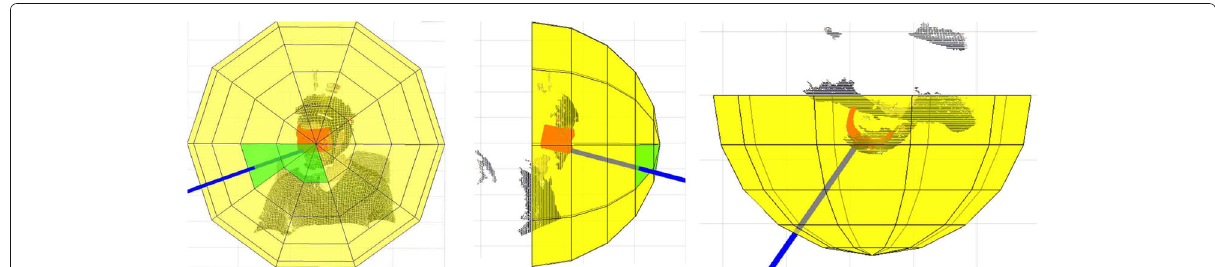
Fig. 3 Key frame learning process. Each figure represents the same target observed from three views. The discretized orientation is depicted as the region of the sphere. The color indicates visited areas (green) from regions without an associated pose (yellow). The set of points in red is the 3D model of the estimated pose. Target orientation at current frame is shown with the blue line